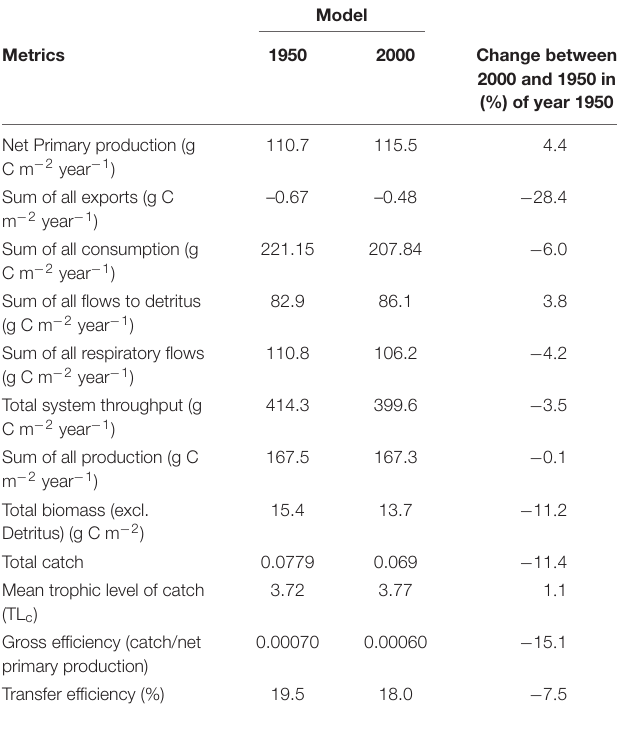
TABLE 4 | Overview of ecosystem metrics for the year 1950 and 2000- Ecopath